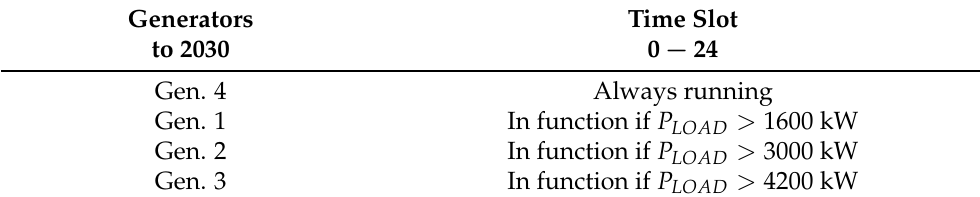
Table 22. Possible Control Logic of Diesel Groups by 2030 with RESs and BESSs: Rest of the Year. Generators